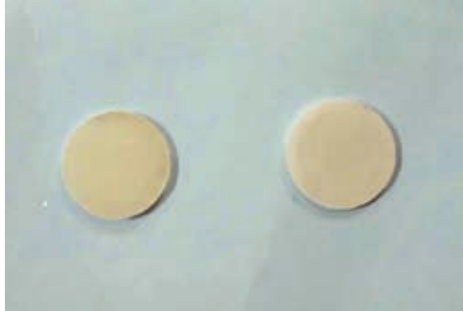
Fig-1 Ultrasonography to detect uroliths